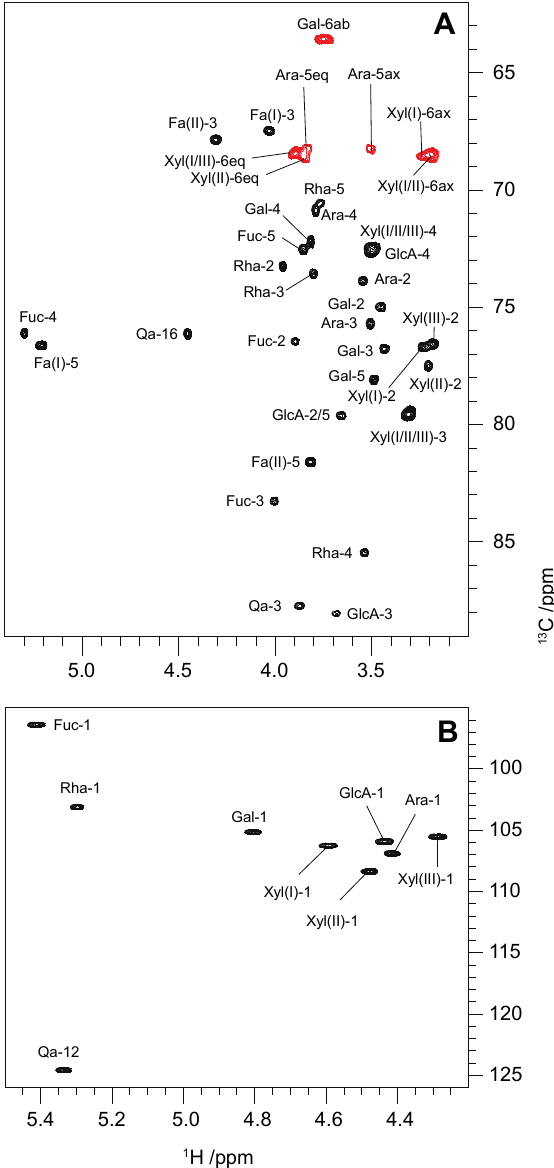
Figure 3. Selected regions of the multiplicity-edited 1 H, 13 C-HSQC spectrum of Qb1 showing the ring and hydroxymethyl groups ( A ) and the anomeric region ( B ). In the first figure ( A ), the CH 2 groups correlations appear in red.